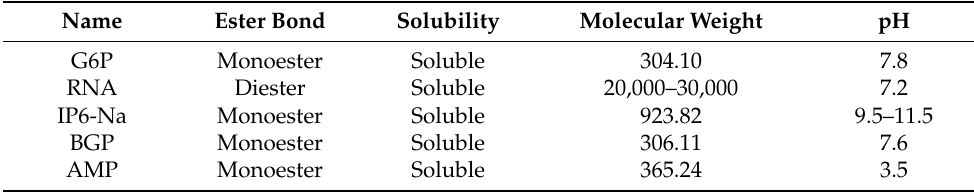
Table 1. The properties of organic phosphorus used in this